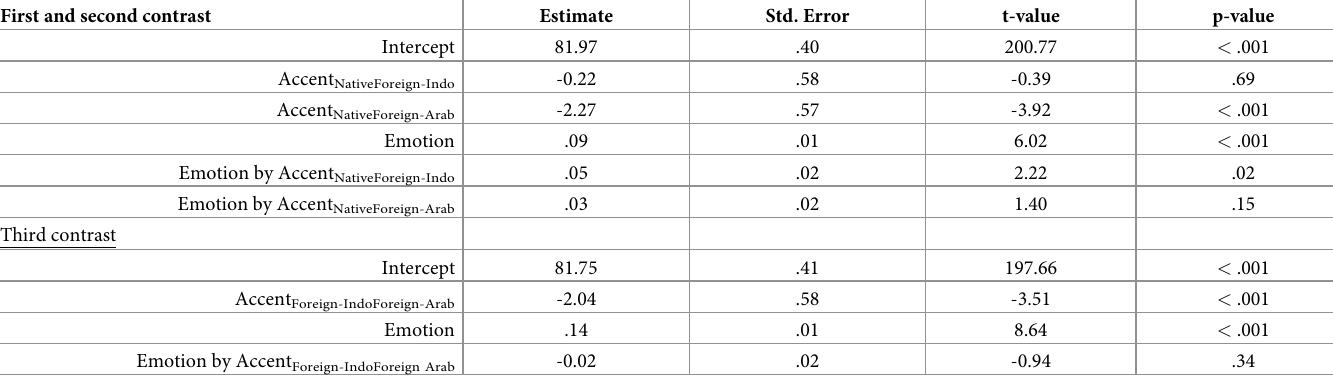
Table 10. Estimates, standard error, t-values, and p-values of the predictors Accent (Accent NativeForeign-Indo , Accent NativeForeign-Arab , and Accent Foreign-IndoForeign- Arab ), Emotion (mean for anger, disgust, discomfort, sadness, and preoccupation), and their interaction on Wrong for the first, second (top panel), and third con- trast (bottom panel). First and second contrast